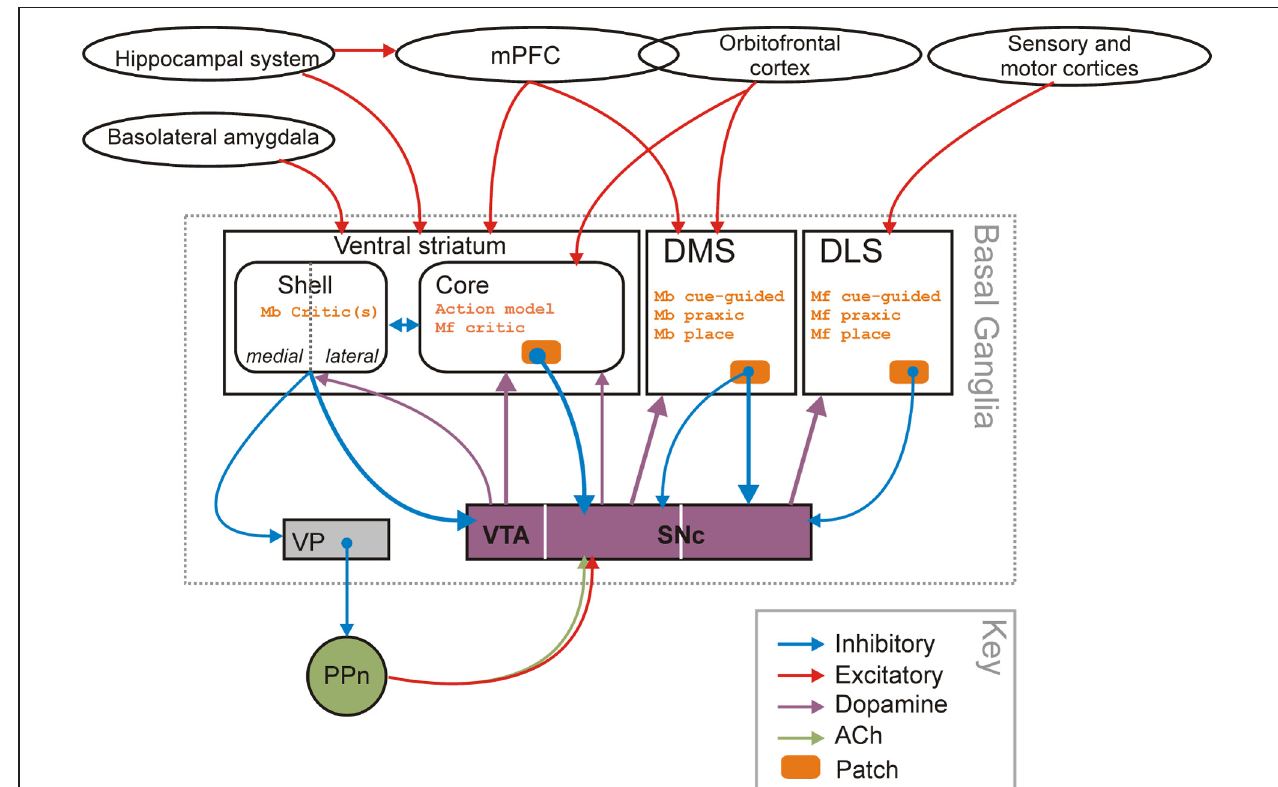
FIGURE 6 | Striatal-domain substrates of model-free and model-based controllers. The proposed organization of navigation strategies and potential control of learning across the three striatal domains. The identification of the shell and core as “critics” for the model-based and model-free controllers in dorsal striatum partly rests on the “spiral” of striatal-dopamine-striatal projections (Maurin et al., 1999; Haber et al., 2000; Haber, 2003), originating in the shell of the VS (the spiral is indicated by the thicker lines) and on the permissive role dopamine plays in plasticity at cortico-striatal synapses (Reynolds et al., 2001; Shen et al.,